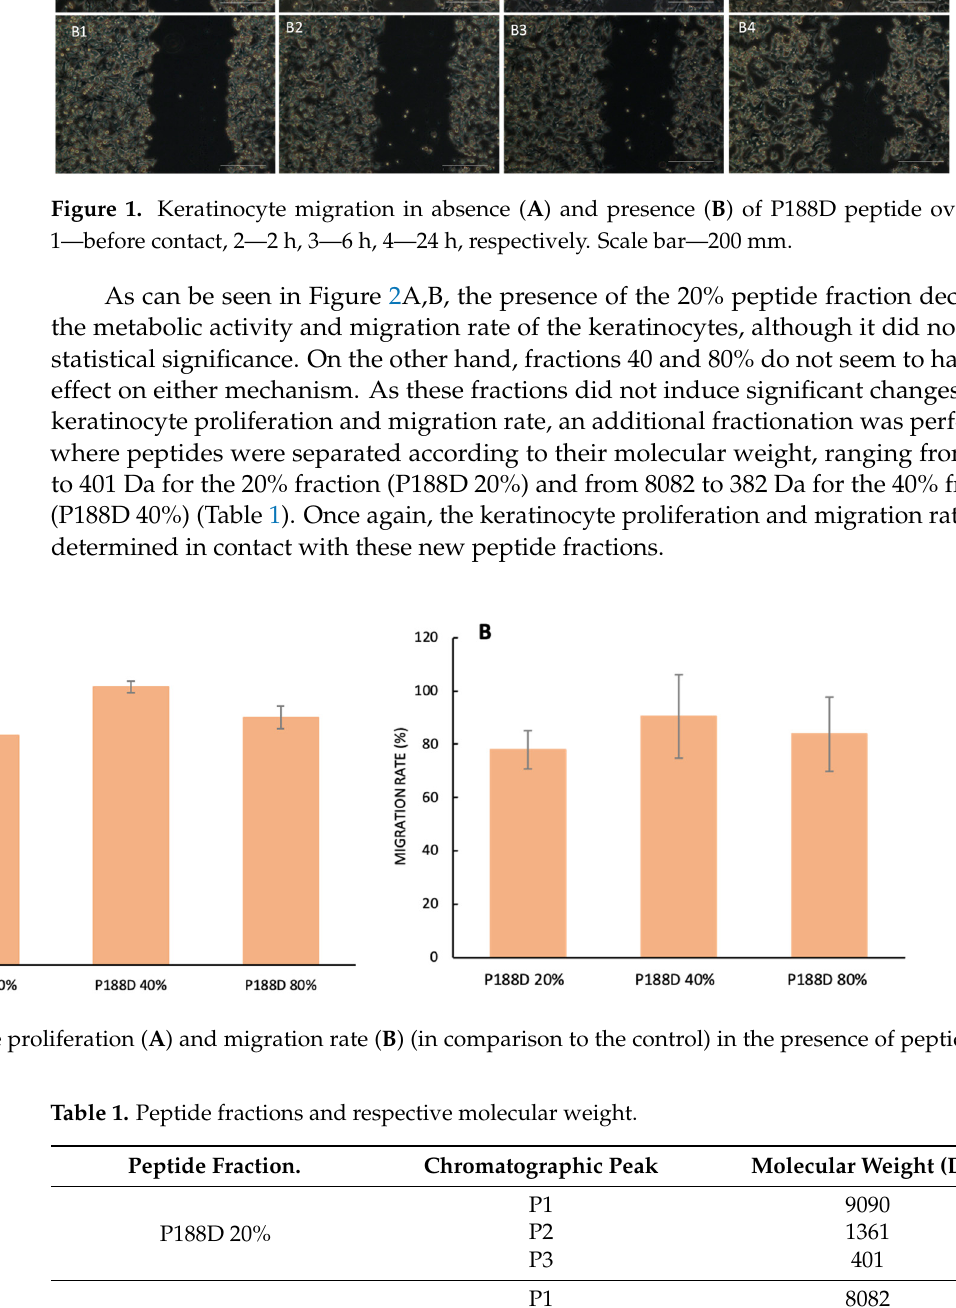
Figure 2. Keratinocyte proliferation ( A ) and migration rate ( B ) (in comparison to the control) in the presence of peptide fractions (45 g/mL). Table 1. Peptide fractions and respective molecular weight.